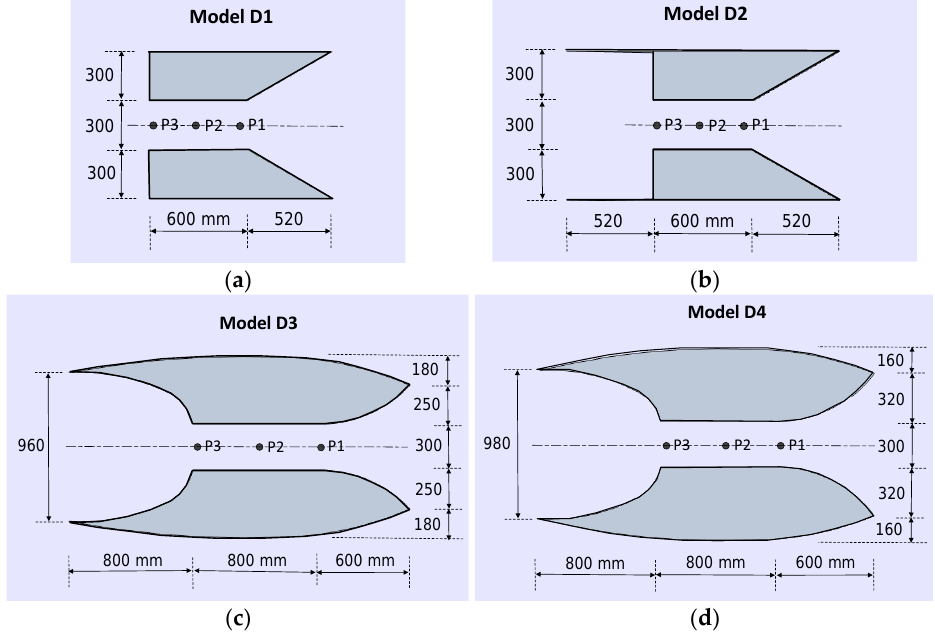
Figure 2. Dimensioned profiles of the four representative duct scale models analyzed, as follows: D1 ( a ), D2 ( b ), D3 ( c ), and D4 ( d ).